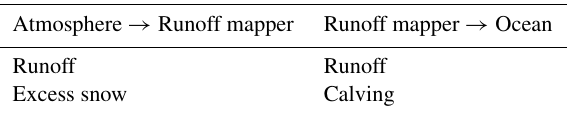
Table 4. Variables and fluxes provided to the ocean via the runoff